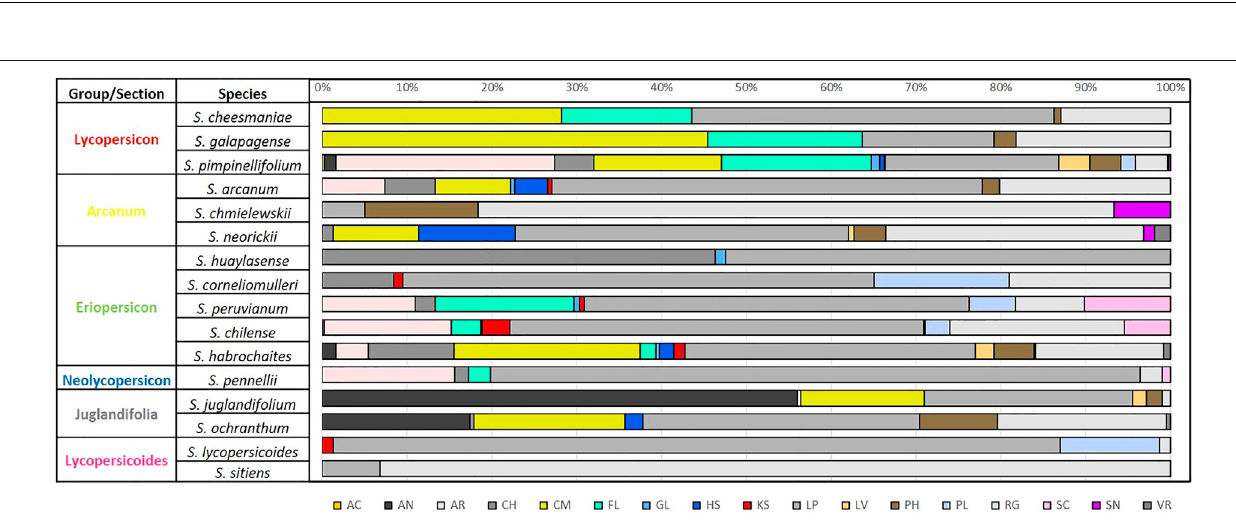
Frontiers in Genetics |